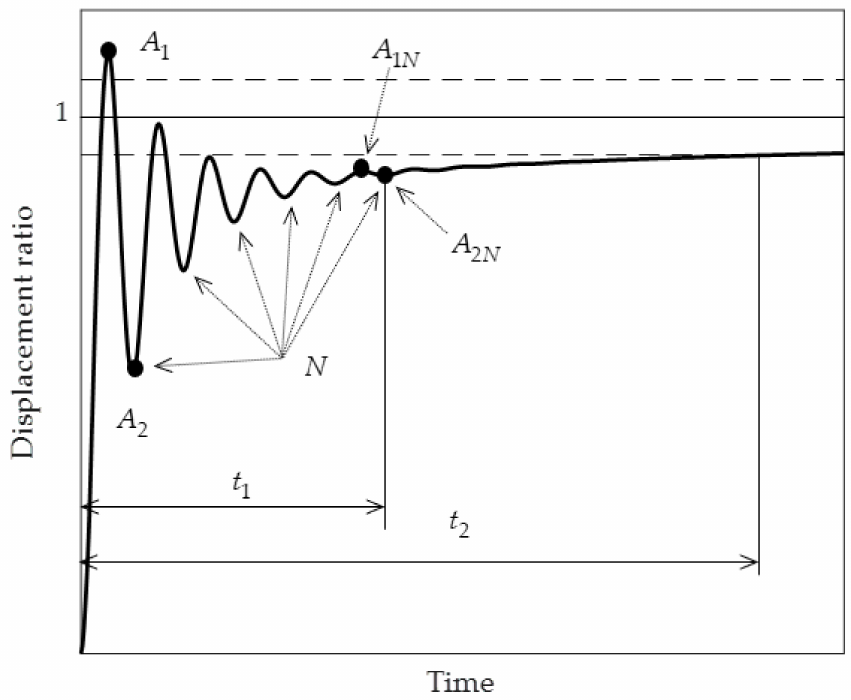
) represent the ± 2.5%